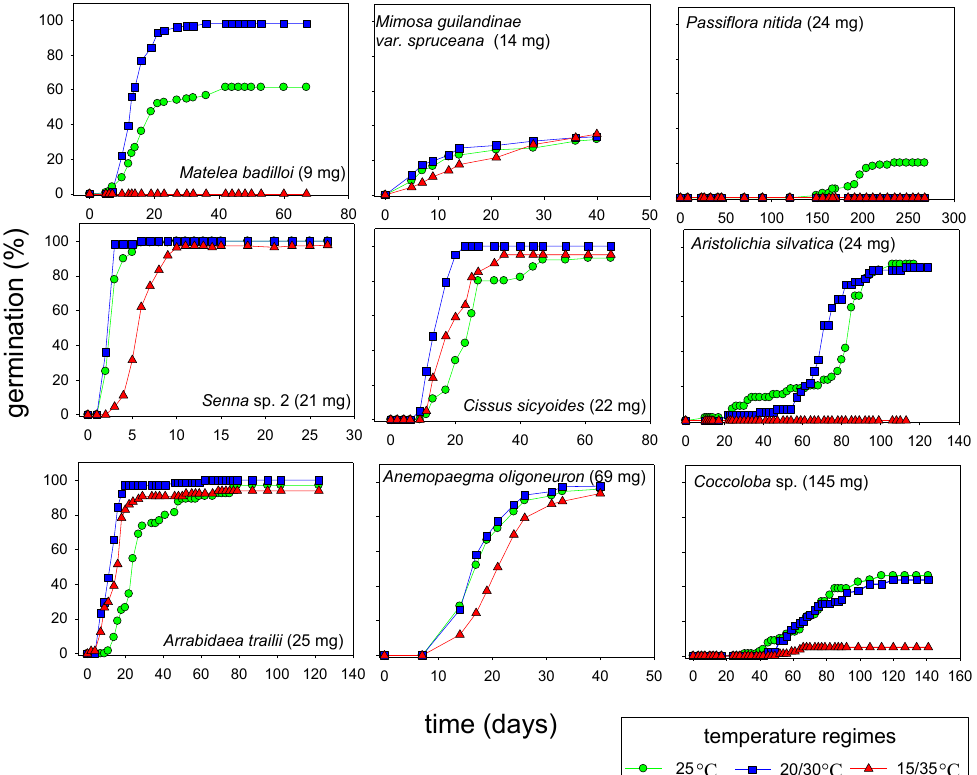
Figure 2. Germination curves of nine liana species of the Central Amazon at constant (25 °C) or 12/12 h alternating temperatures (20/30 °C, 15/35 °C) with 12 h light daily. The species were ordered by increasing seed resources (dry mass of embryo and endosperm), dry mass of whole seed is given in brackets. For significant differences of final germination between temperature conditions see Table